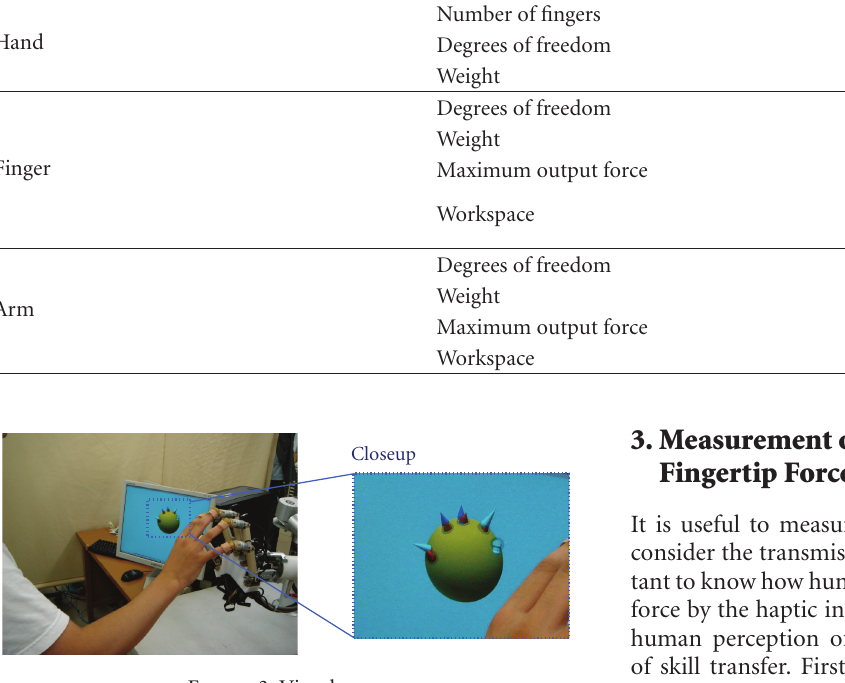
Figure 3: Visual